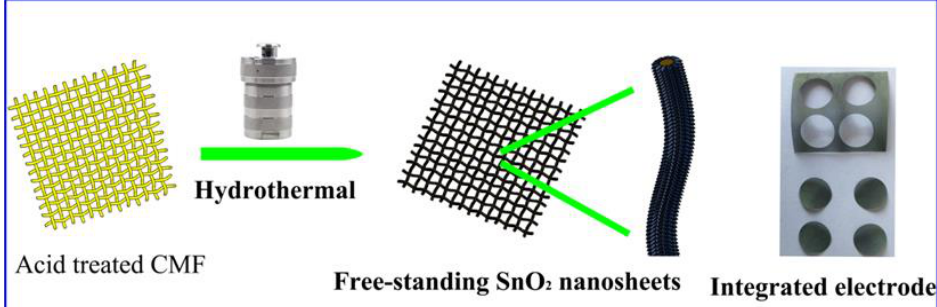
Figure 1. A schematic diagram for the fabrication procedure of SnO 2 nanosheets on the